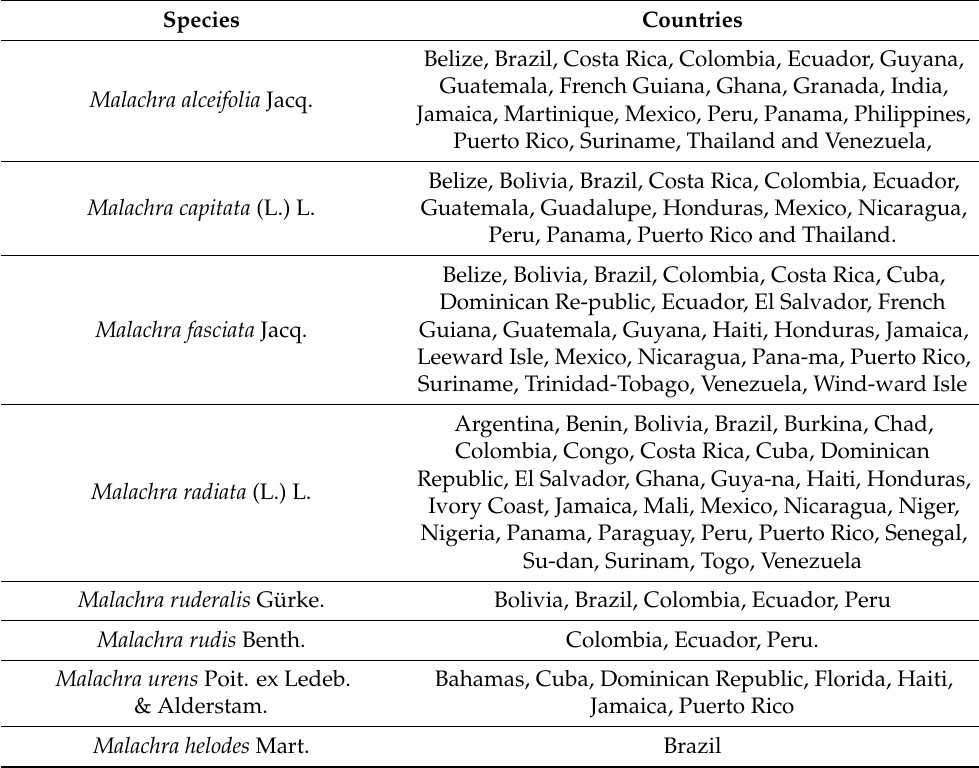
Table 3. Global geographical distribution of the species of the genus Malachra L.